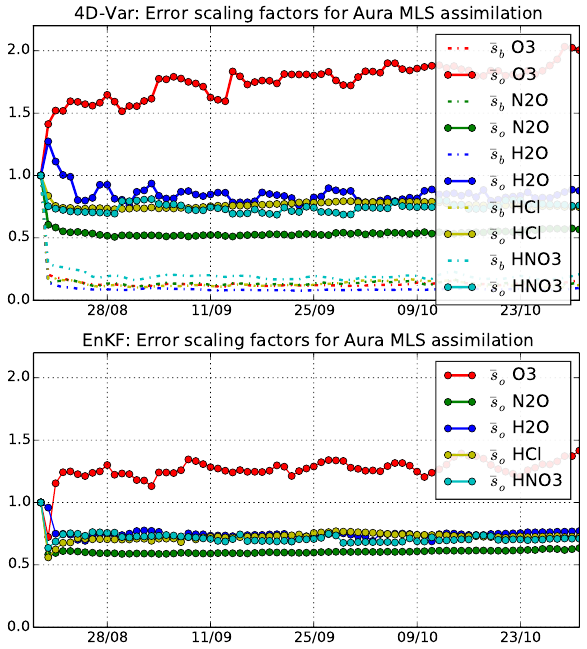
Figure 3. Estimated error scale factors within 4D-Var (left) and EnKF (right) for the period April–November